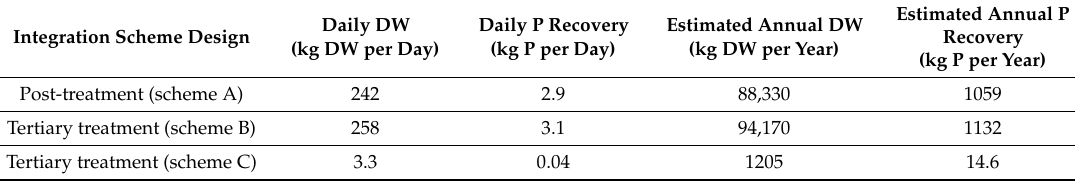
Table 5. Estimated P recovery potential of a microalgal biofilm system for the three proposed designs. The values were calculated based on the required areas. Daily DW—biomass production per day expressed as dry weight biomass for the required area; Daily P recovery—the amount of P captured in the microalgal biomass per day; Estimated annual DW—biomass production per year expressed as dry weight biomass for the required area; Estimated P recovery—the amount of P captured in the microalgal biomass per